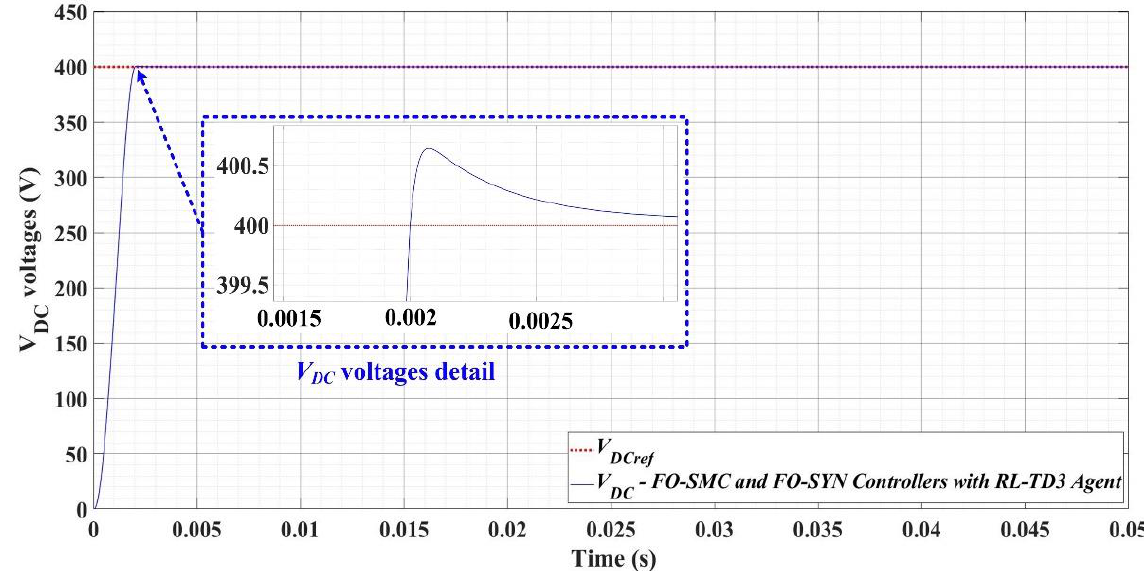
Figure 19. V DC voltage time evolution based on FO SMC and FO synergetic controllers combined with RL-TD3 agent for control system of the power electronic converter in the case of a DC microgrid current for DC bus 2 i 0 = 100 A.